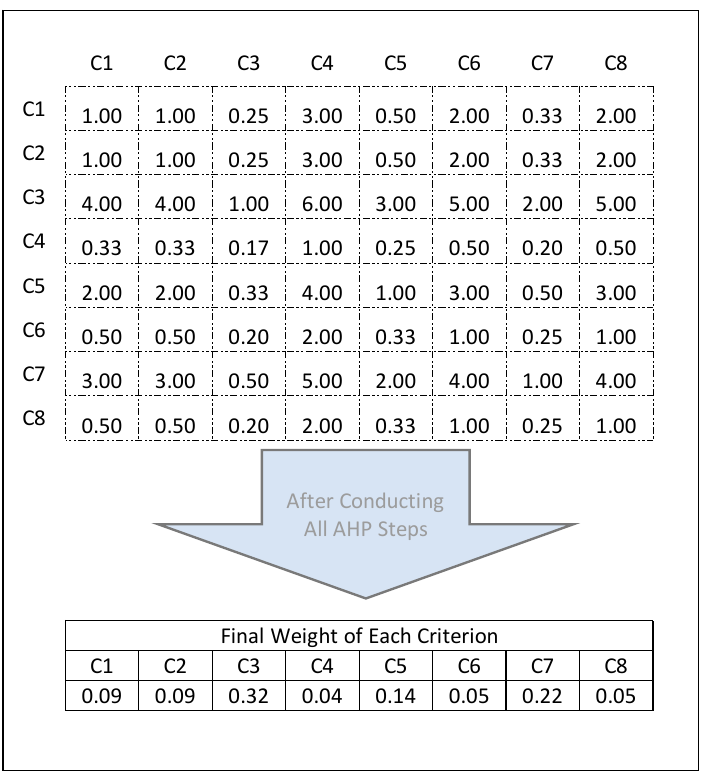
Figure 1. Final weight of each criterion in the analytic hierarchy process.